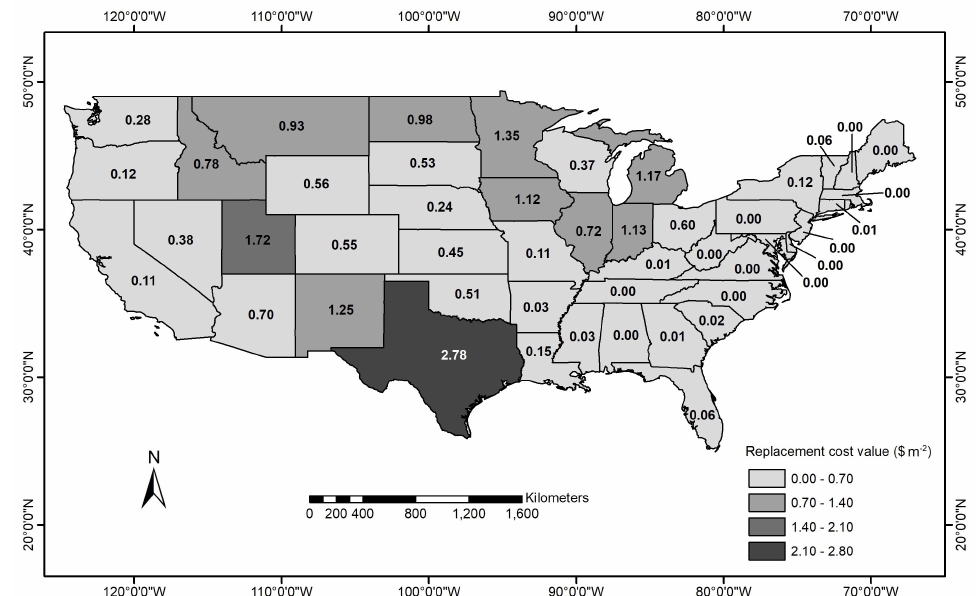
Figure 2. The midpoint replacement cost value ($ m − 2 ) of SIC in the contiguous United States based Figure 2. DInSAR analysis. ( a , b ) DInSAR (Line-of-sight [LOS]) displacement maps computed by using on [9] and a 2014 average price for limestone of $10.42 per U.S. ton [24]. ALOS-2 images acquired from: ( a ) ascending orbits on 24 August–2 November 2016 and ( b ) descending orbits on 31 August–9 November 2016; ( c ) vertical displacement map computed by exploiting the ascending and descending ALOS-2 measurements shown in panels ( a , b ), and including both the M w 5.9 Visso and the M w 6.5 Norcia earthquakes. The magenta rectangle indicates the area considered in The regions with the highest midpoint total replacement cost value of SIC storage were: (1) South Figure 3a; ( d ) E-W displacement map computed by exploiting the ascending and descending ALOS-2 Central ($1.95T), (2) West ($1.23T) and (3) Northern Plains ($1.01T) (Table 4). On an area basis, the measurements shown in panels ( a , b ), and including both the effect of the M w 5.9 Visso and the M w 6.5 regions were ranked: (1) South Central ($1.80 m − 2 ), (2) Midwest ($0.82 m − 2 ) and (3) West ($0.63 m − 2 ) Norcia earthquakes. The white star represents the M w 6.5 Norcia mainshock. The white and black lines (Figure 3). represent the contour lines of the maximum deformation zones and the main faults located in this area (i.e., MGF and MVFS), respectively. Table 1. Coseismic interferometric pairs exploited for the DInSAR analysis. ALOS-2 data pairs involving both the 26 October Visso and the 30 October Norcia events.